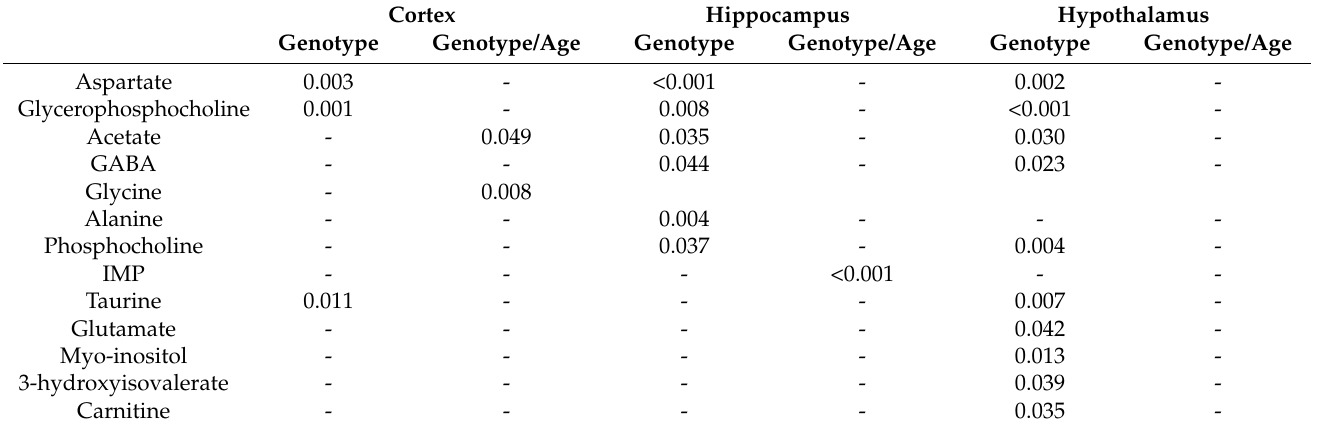
(Table 1). Interestingly, the four cecal metabolites that emerged from the multi-omics inte- gration analysis (5-aminopentanoate, glucose-6-phosphate, butyrate, and valerate) were found to be significantly correlated with several cortical, hippocampal, and hypothalamic metabolites (Pearson correlation). These results are shown in Supplementary Figure S6. Table 1. Results of 2-way ANOVA against genotype and age for brain